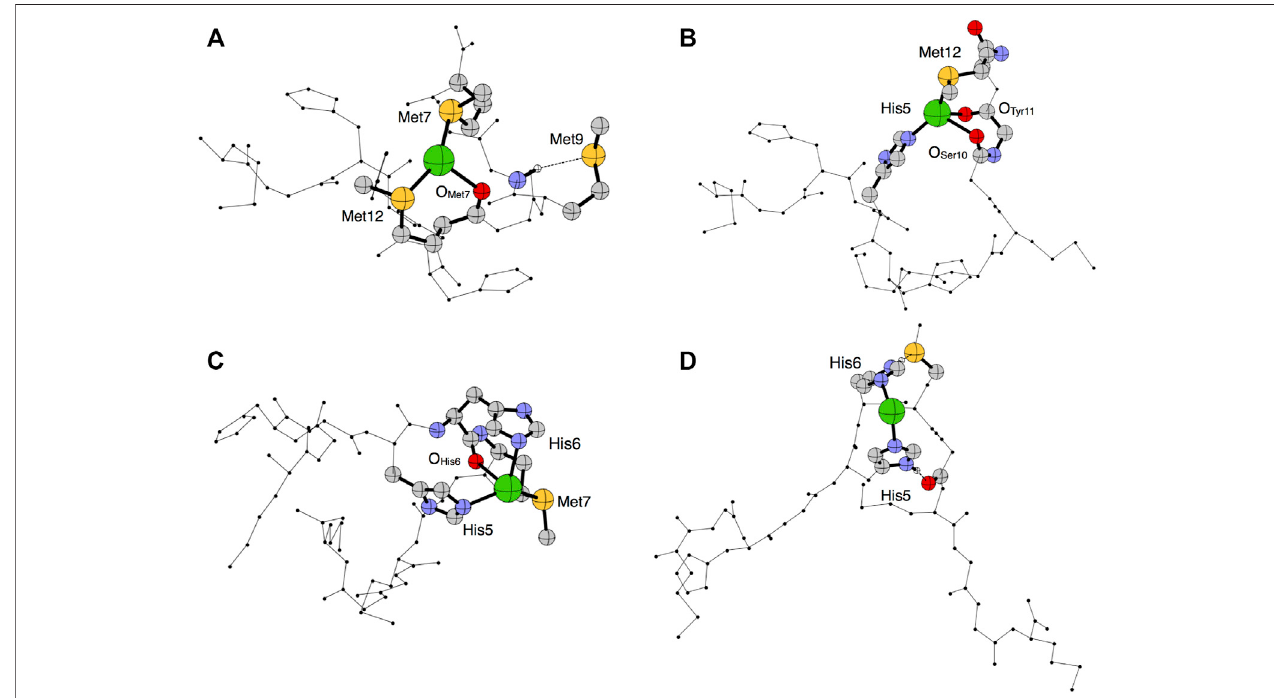
FIGURE 7 | Optimized structural models 1 – 4 (A – D) predicted in the PBE/DGDZVP framework for Ag(I)-Ctr1 1-14 . The silver ion is shown in green, oxygen in red, nitrogen in blue, carbon in gray and sulfur in yellow.